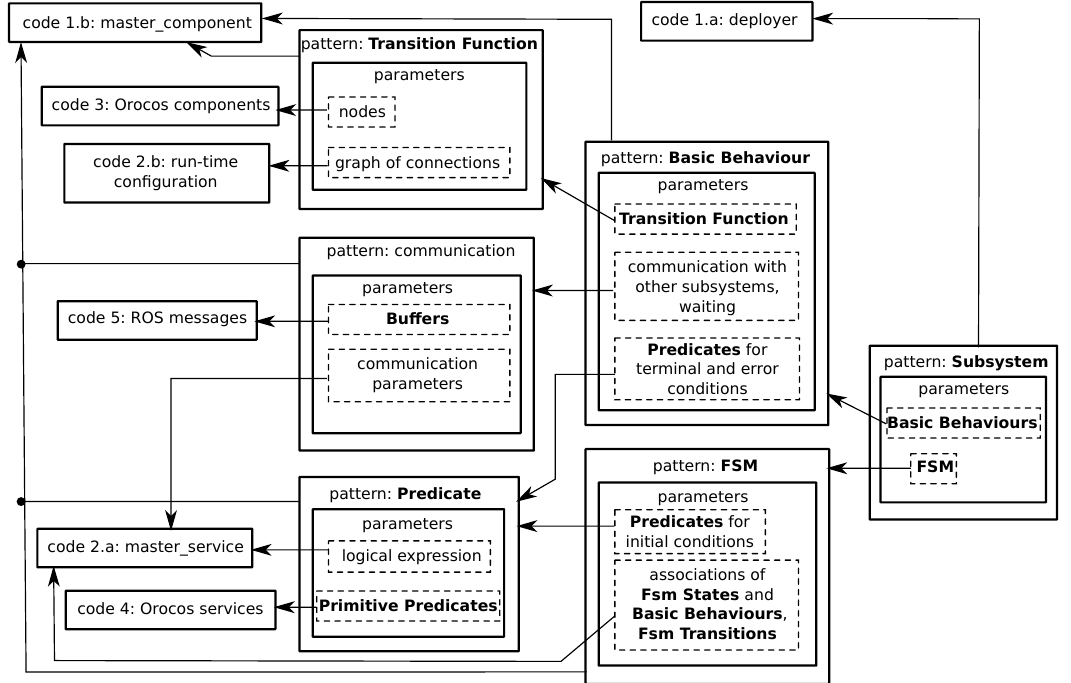
Figure 16. Specification decomposition into patterns and their parameters at various levels of generality [16]. Parameters are implemented using either code, or patterns at lower level of generality. Patterns are expressed as code. Arrows point from more general entities to more specific, i.e., their